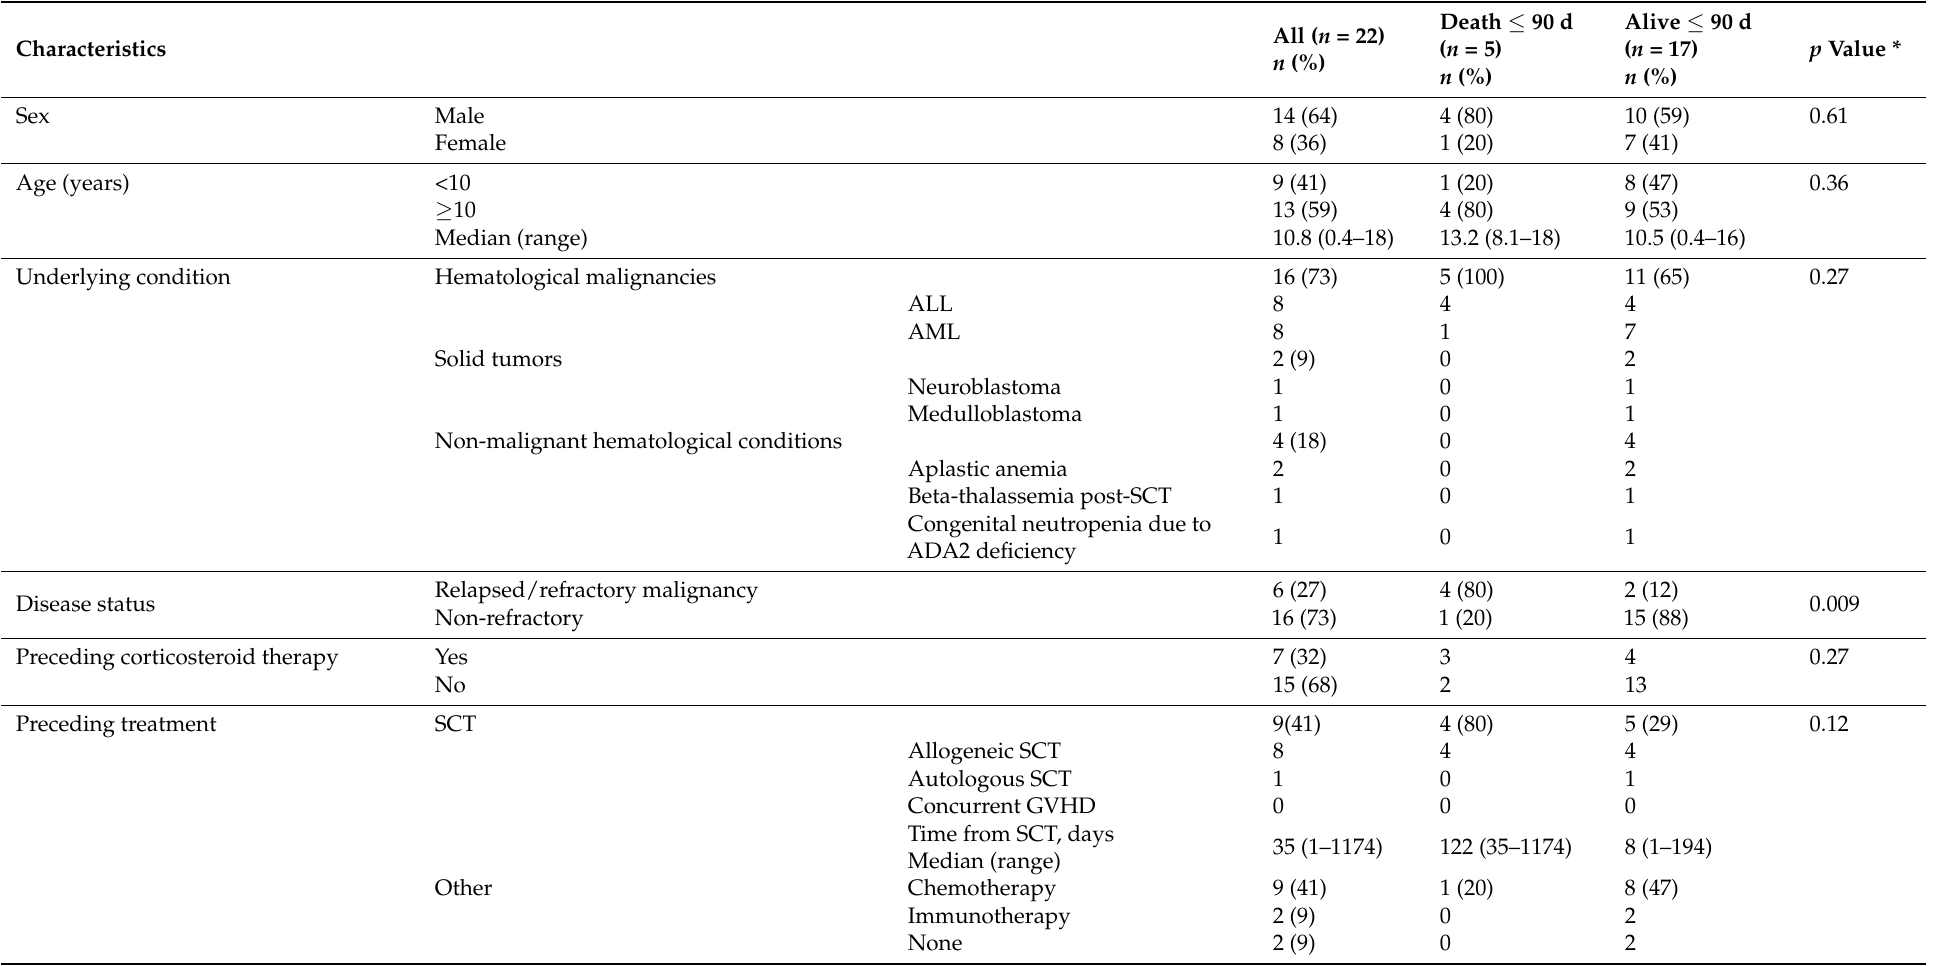
Table 1. Demographics, infection patterns, and treatment of